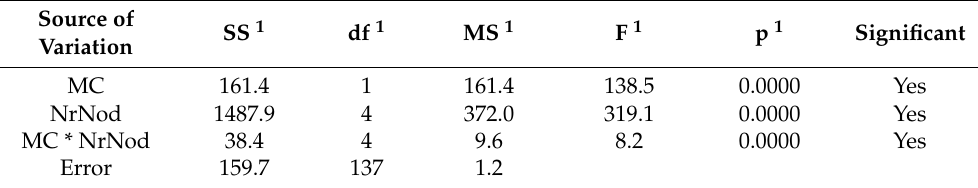
Table 6. Two-way ANOVA results for maximum stress in compression ( σ comp ). Source of Variation